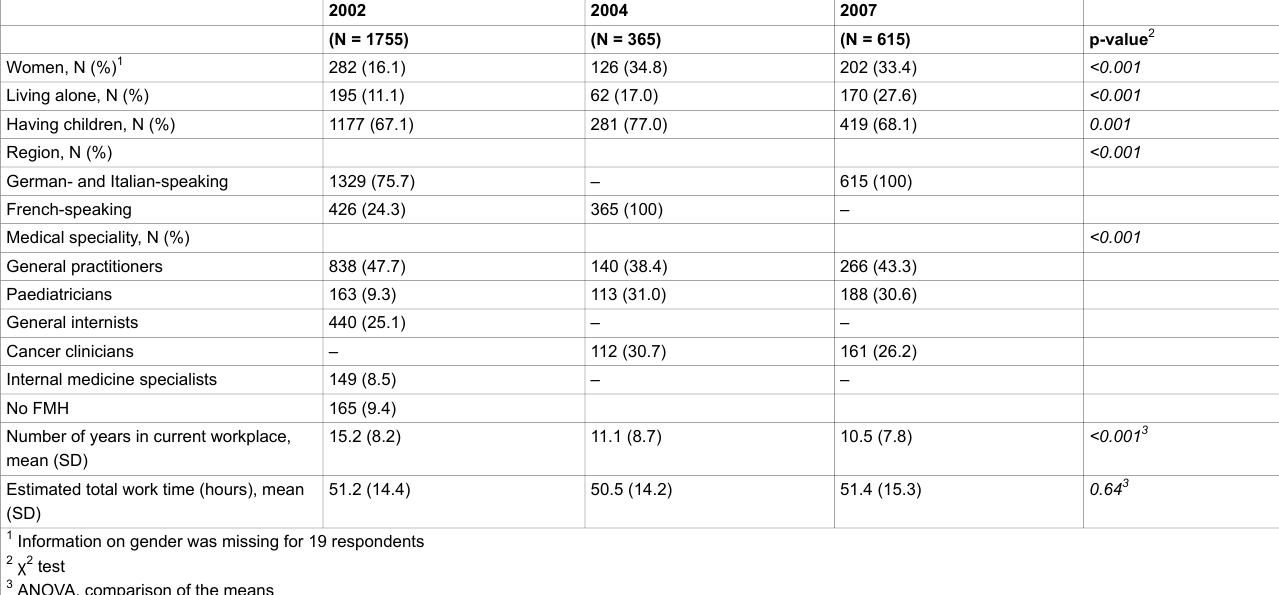
Table 1 Socio-demographic characteristics of 2735 Swiss doctors surveyed by the Maslach Burnout Inventory between 2002 and 2007.